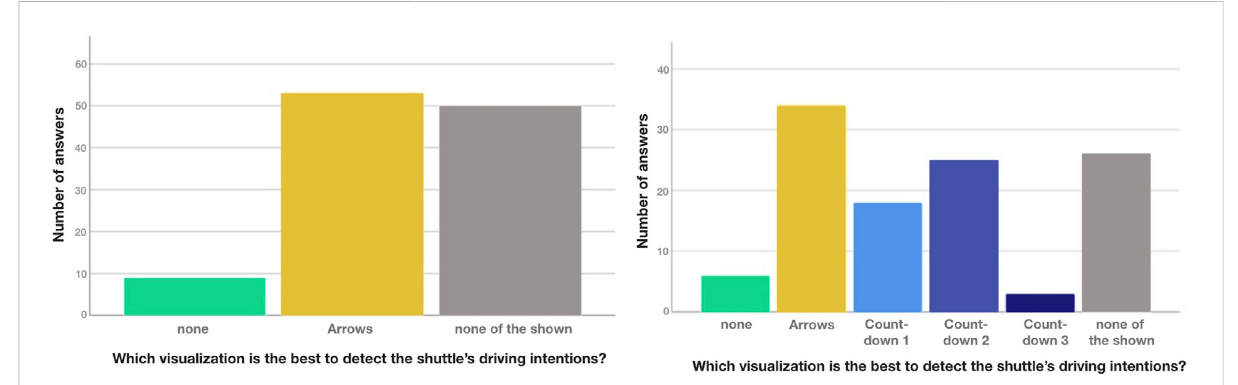
FIGURE 12 Preferred eHMI for detect shuttle ’ s intentions at T-junction 1A and 1B